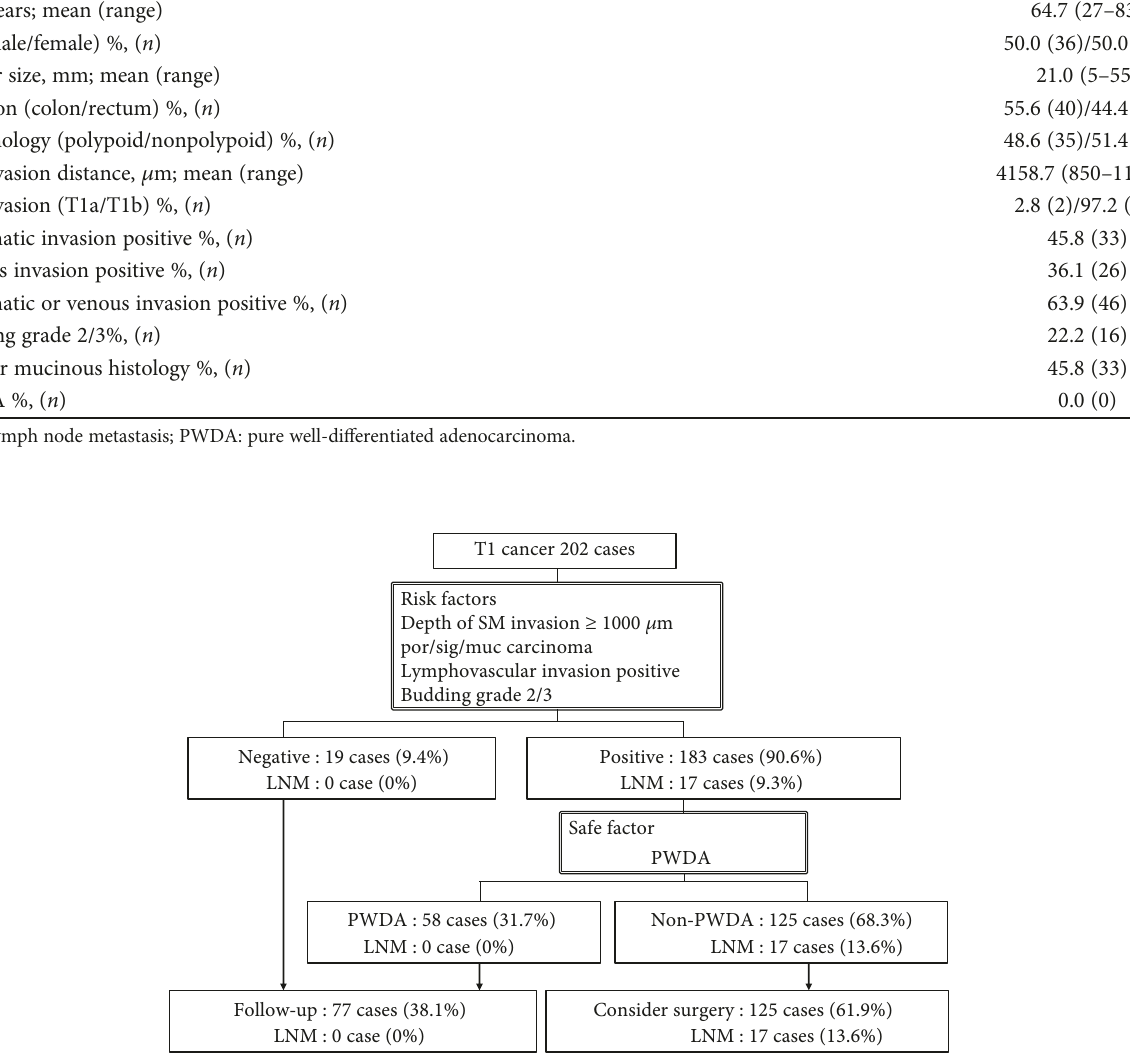
Figure 4: A simulation adopting PDWA as a safe factor in T1 cancers. PWDA: pure well-di ff erentiated adenocarcinoma; SM: submucosal; LNM: lymph node